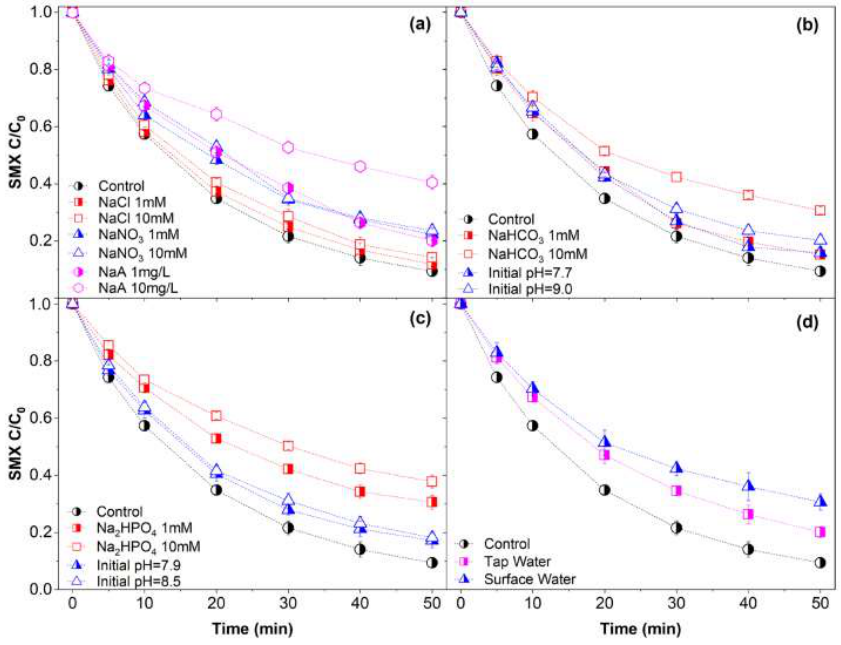
Figure 6. Effects of ( a ) Cl − , NO 3 − and A − , ( b ) HCO 3 − , ( c ) HPO 42 − ( d ) tap water, surface water on SMX degradation by PDS/CuO@CNT. Conditions: SMX = 39.5 µ M, PDS = 1.0 mM, CuO@CNT = 0.1 g/L.